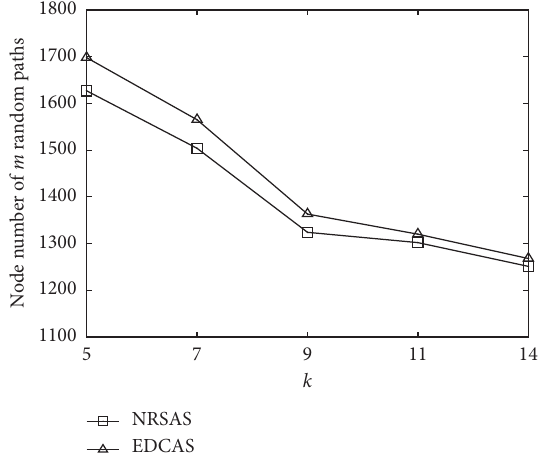
Figure 11: The effect of the node number on the random